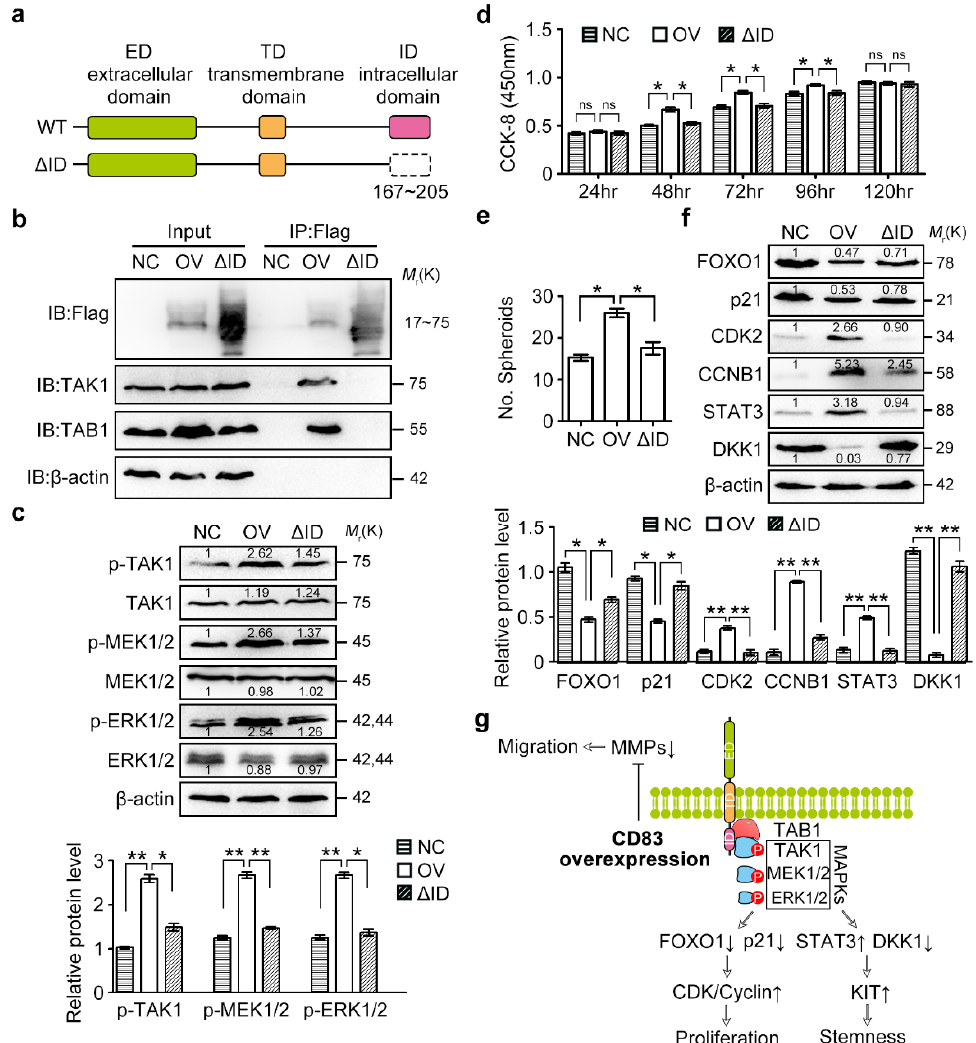
Figure 6. CD83 functioned through its intracellular domain that associated with the TAK1 / TAB1 complex. ( a ) Schematic representation of CD83 protein and the truncated mutant. CD83 protein includes the extracellular domain (ED), the transmembrane domain (TD), and the intracellular domain (ID). The CD83 mutant without the ID was named as CD83 ∆ ID. ( b ) Co-IP was performed after